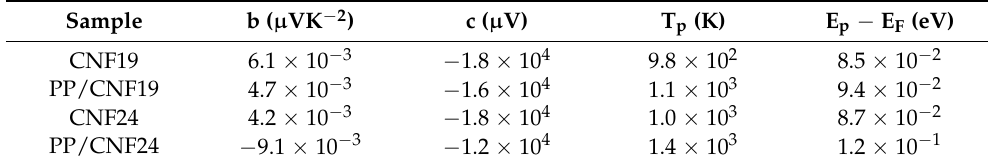
Table 6. Constants b, c, T P and E P − E F obtained by Equation (3) of CNFs and PP/CNF